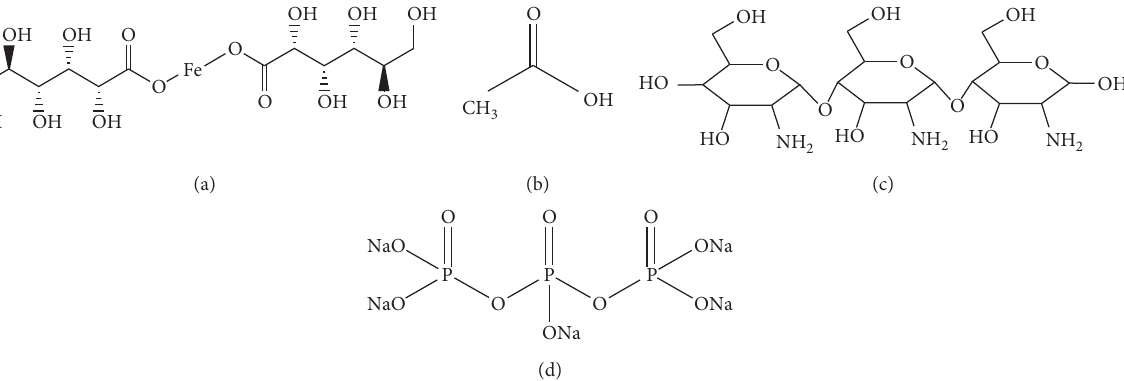
Figure 1: Molecular structure of (a) FeG, (b) Ac, (c) Ch, and (d)